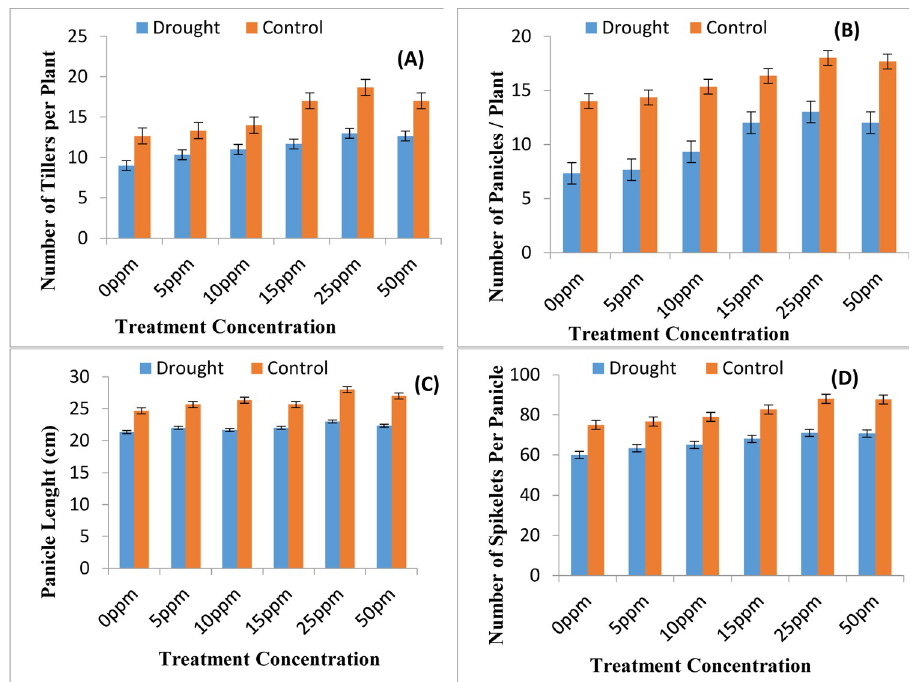
Fig 1. Yield attributes of rice plants. (A) Number of tillers per plant (B) Number of panicles per plant (C) Panicle length and (D) Number of spikelet per panicle as affected by various regimes of ZnONPs under water scarce and well irrigated environment (mean ± SE; n =